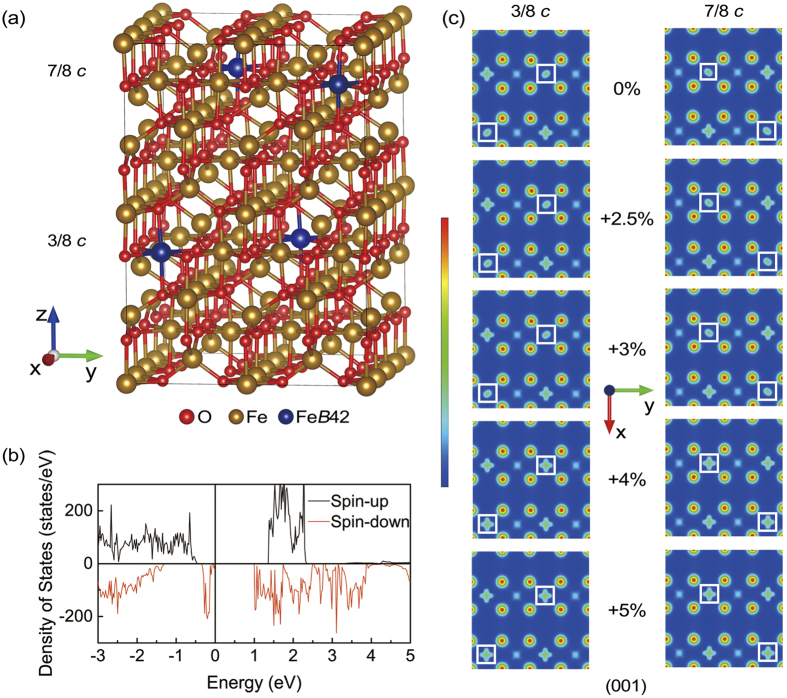
(a) The lattice structure under Cc symmetry. (b) Total DOS of structure (II). (c) Charge density map of spin-down electrons plotted on (001) plane at 3c/8 (left column) and 7/8 c (right column) with different strains. Fe(B42) is shown in the white square.